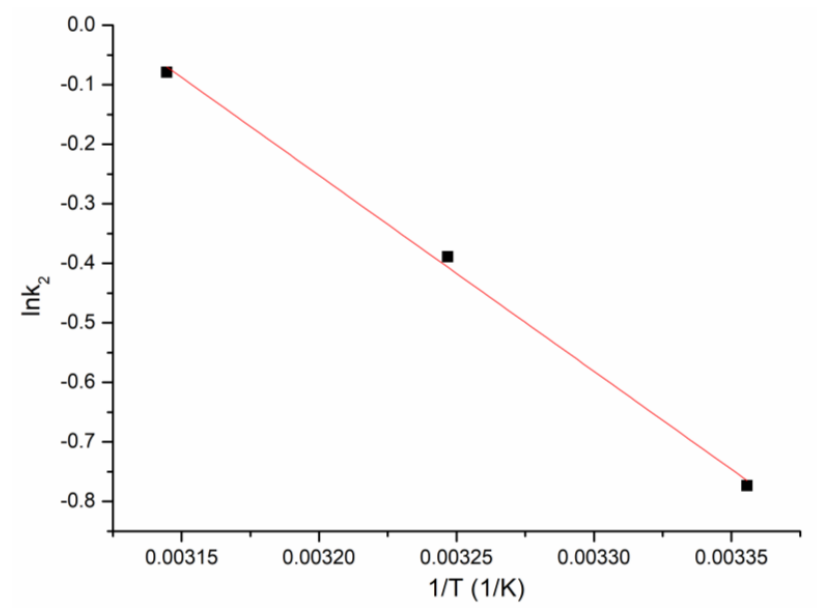
Figure 10. The ln k 2 vs. 1/T